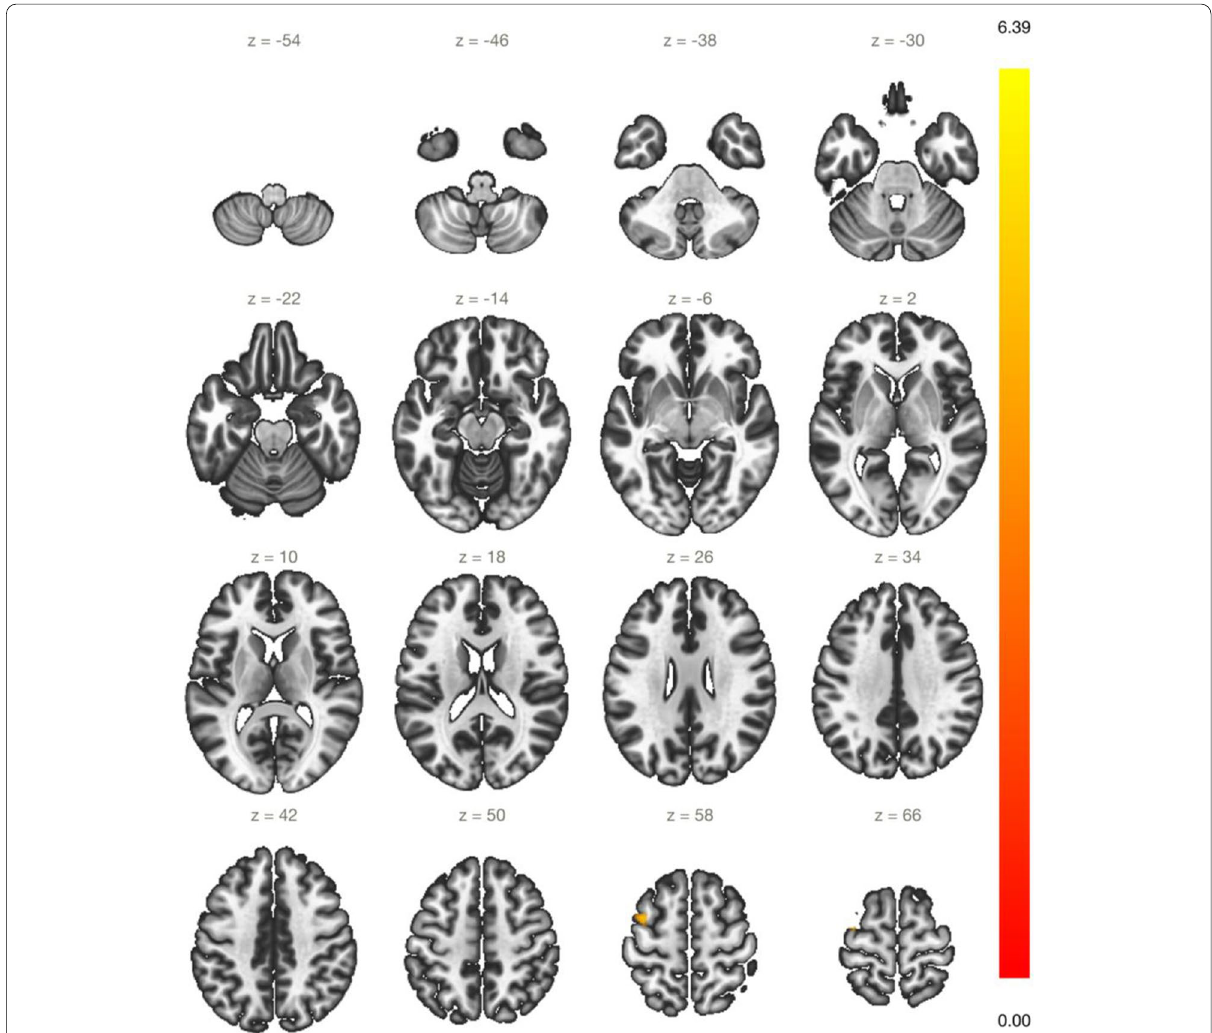
Fig. 1 The functional connectivity seed‑to‑voxel (region of interest) analysis using the salience network as seed region resulted in one significant cluster in left middle frontal and precentral gyrus (threshold: p < 0.05 cluster‑size; p ‑false discovery rate corrected). See Table